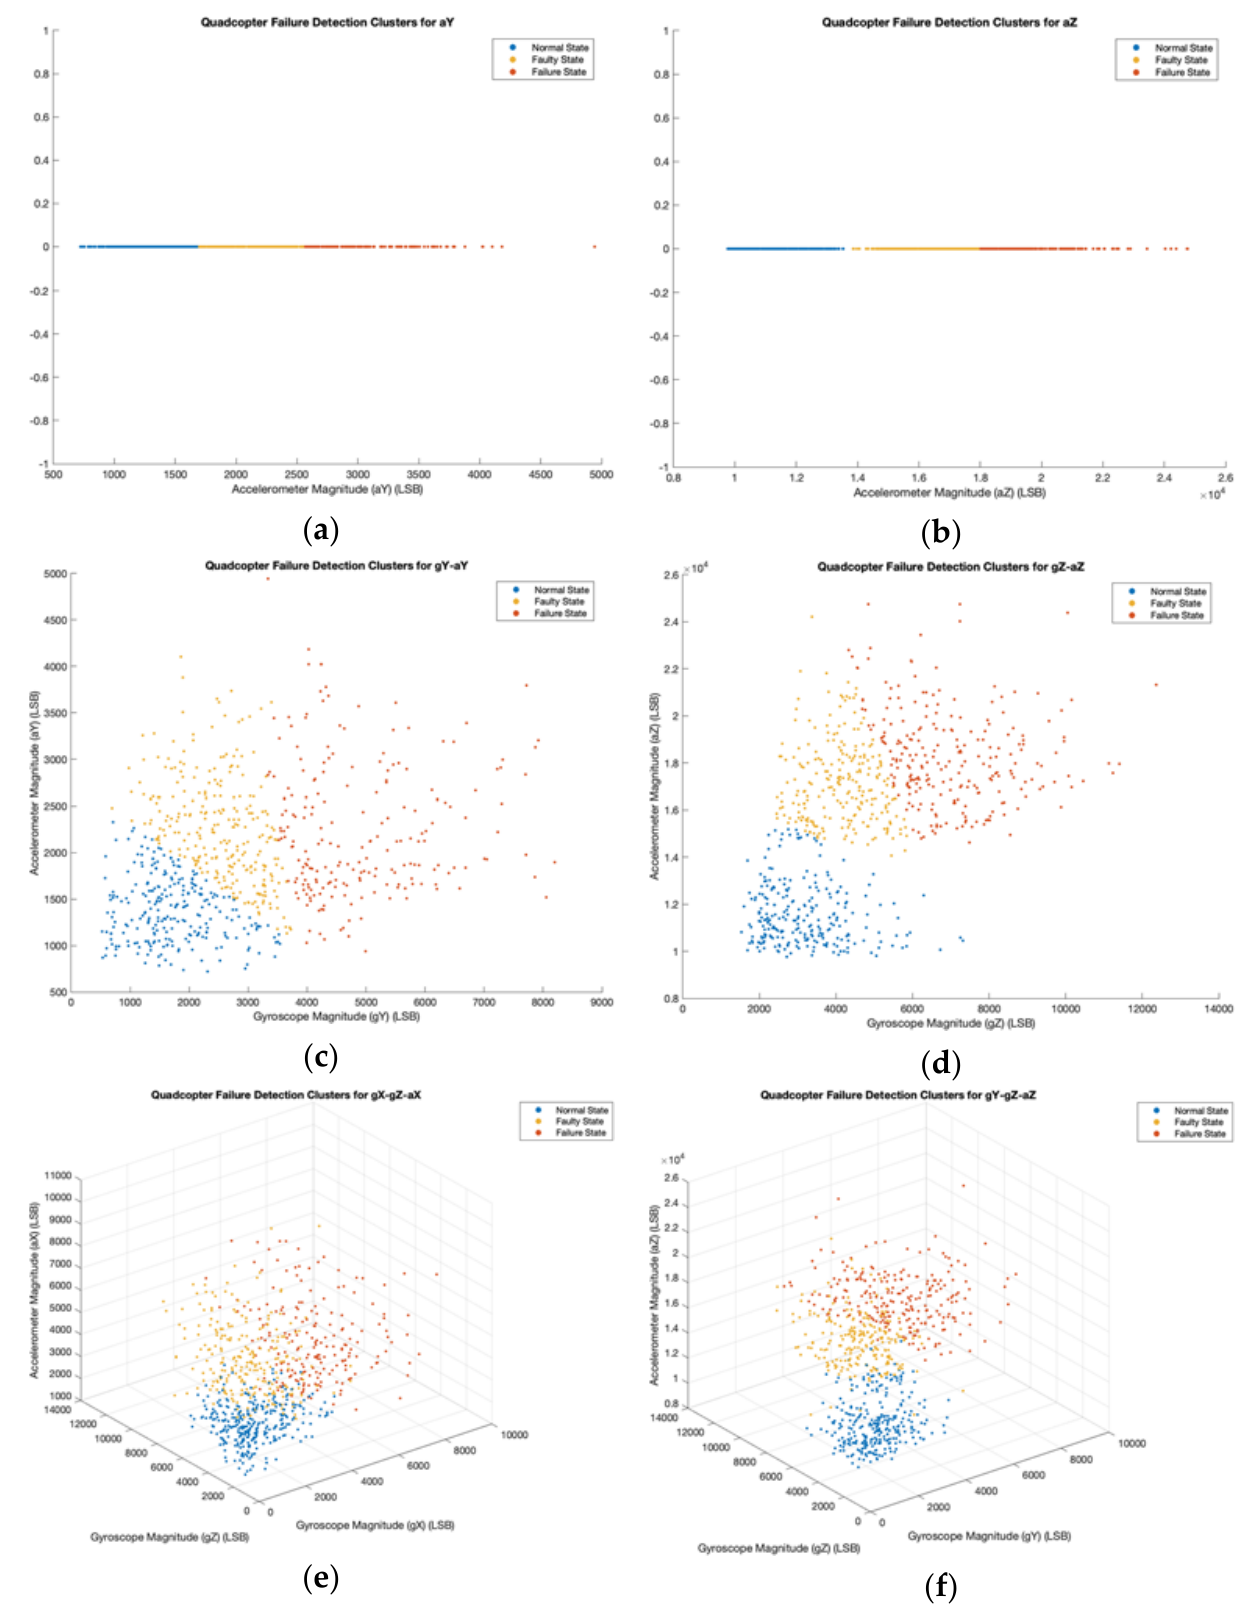
Figure 10. QFDC Plot for ( a ) aY, ( b ) aZ, ( c ) gY-aY, ( d ) gZ-aZ, ( e ) gX-gZ-aX, and ( f ) gY-gZ-aZ.